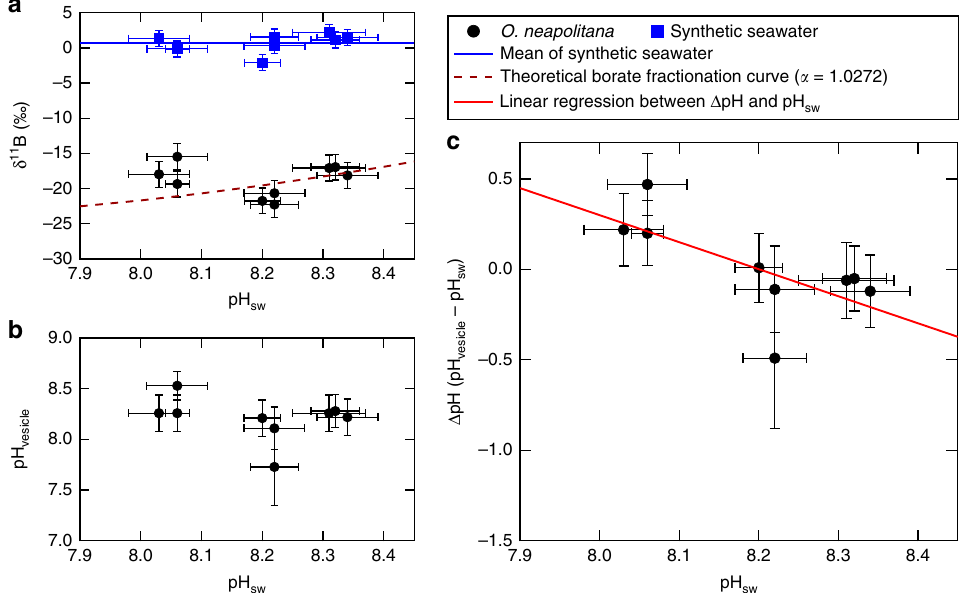
Fig. 2 Seawater pH vs. coccolith δ 11 B and boron-isotope-inferred dynamics of calcifying vesicle pH. a Seawater pH vs. δ 11 B of coccolith calcite (solid black circles), δ 11 B of culture seawater (solid blue squares; blue line is average δ 11 B across treatments), and theoretical δ 11 B of seawater borate (brown dash curve). If total boron δ 11 B and pH of the seawater and calcifying vesicle are identical, and only borate is incorporated into the coccolith calcite, coccolith δ 11 B results should lie on the theoretical δ 11 B-pH SW curve — which is not the case. Deviation from this relationship under the most acidi fi ed treatment is interpreted as re fl ecting biological elevation of pH at the site of calci fi cation. b Seawater pH vs. coccolith vesicle pH inferred from δ 11 B of coccolith calcite, and temperature, salinity, and δ 11 B of seawater. c Seawater pH vs. offset between coccolith calci fi cation site pH and culture seawater pH ( Δ pH). The linear regression between Δ pH and seawater pH (pH sw ) is shown in red. Error bars are 2 SD for y -axis and 1 SD for x